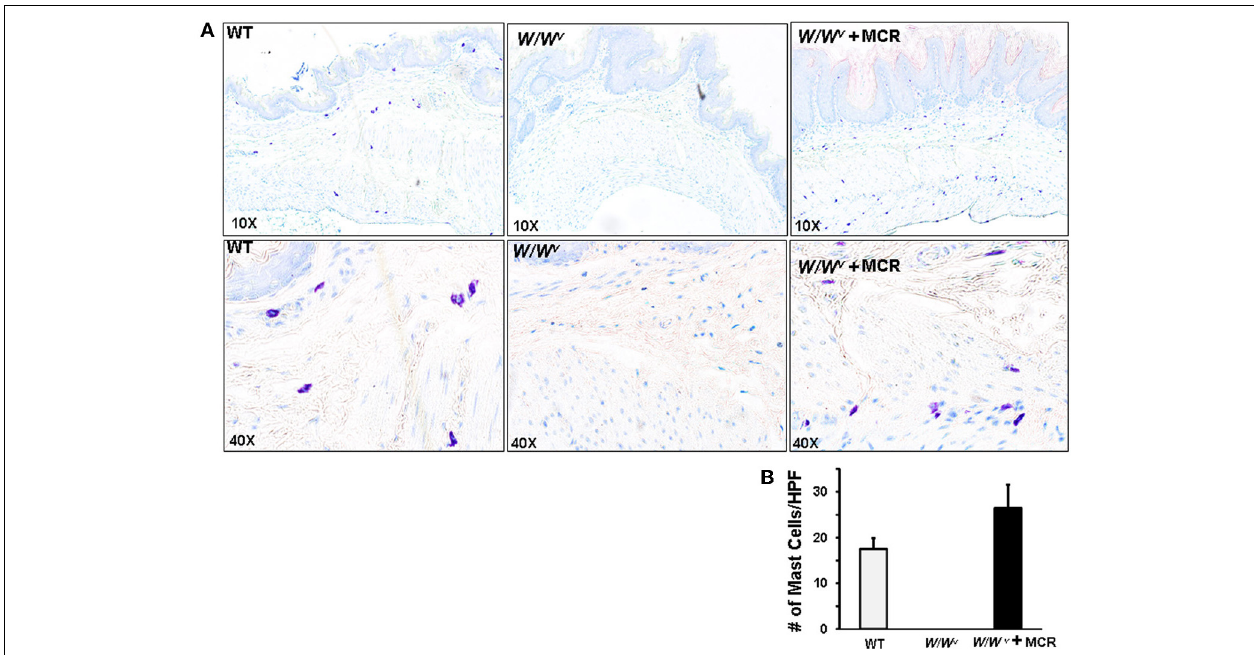
FIGURE 2 | Mast cell counts in fundus of WT, W/W v and W/W v + mast cell reconstitution (MCR). (A) Panels show formalin fixed paraffin embedded cross sections of fundus tissue stained with the mast cell stain toluidine O. Mast cells appear purple. Top panels are at 10X magnification and bottom panels are 40X